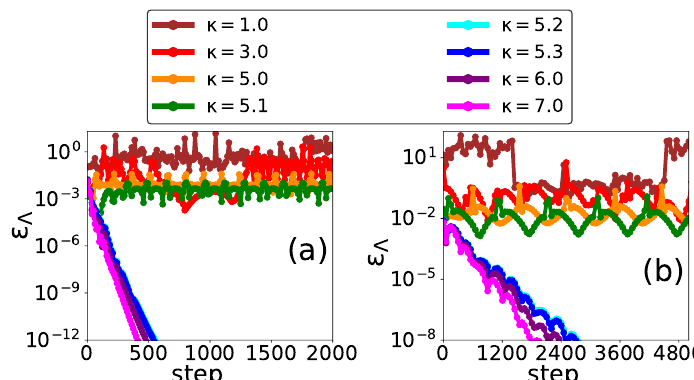
= 1.2 for selected values of κ during the adiabatic Figure 5: The evolution of ε Λ at J y parameter sweep from a strong dissipation regime with κ = 8 to a weak dissipation regime with κ = 1 in steps of ∆ κ = 0.1 and using timesteps (a) δ t = 10 − 2 , (b) δ t = 10 − 3 . All other parameters are the same as in Fig. 1. Energies given in units of κ =